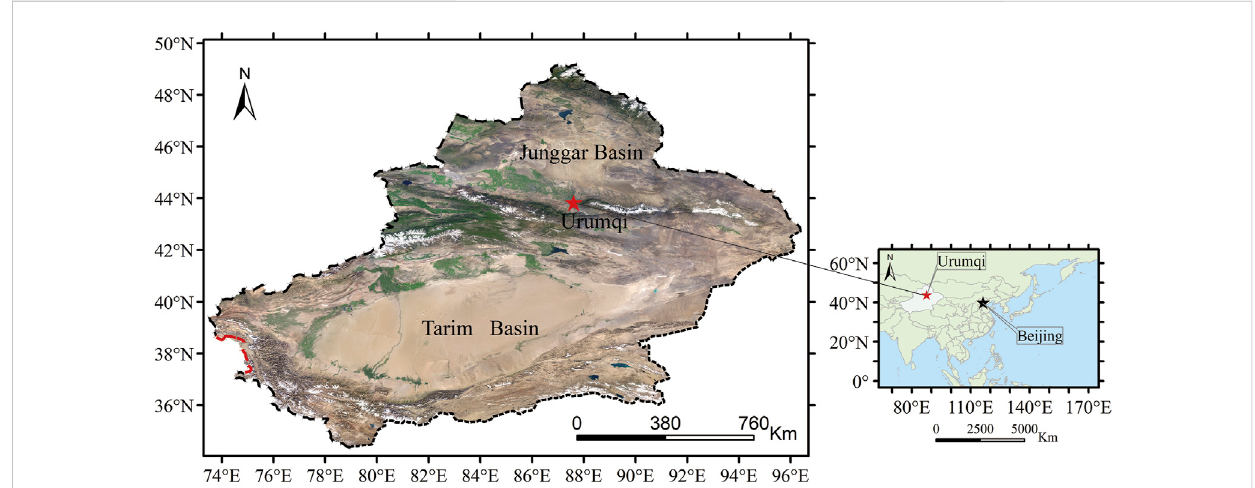
FIGURE 1 Geographical location and terrain of Xinjiang